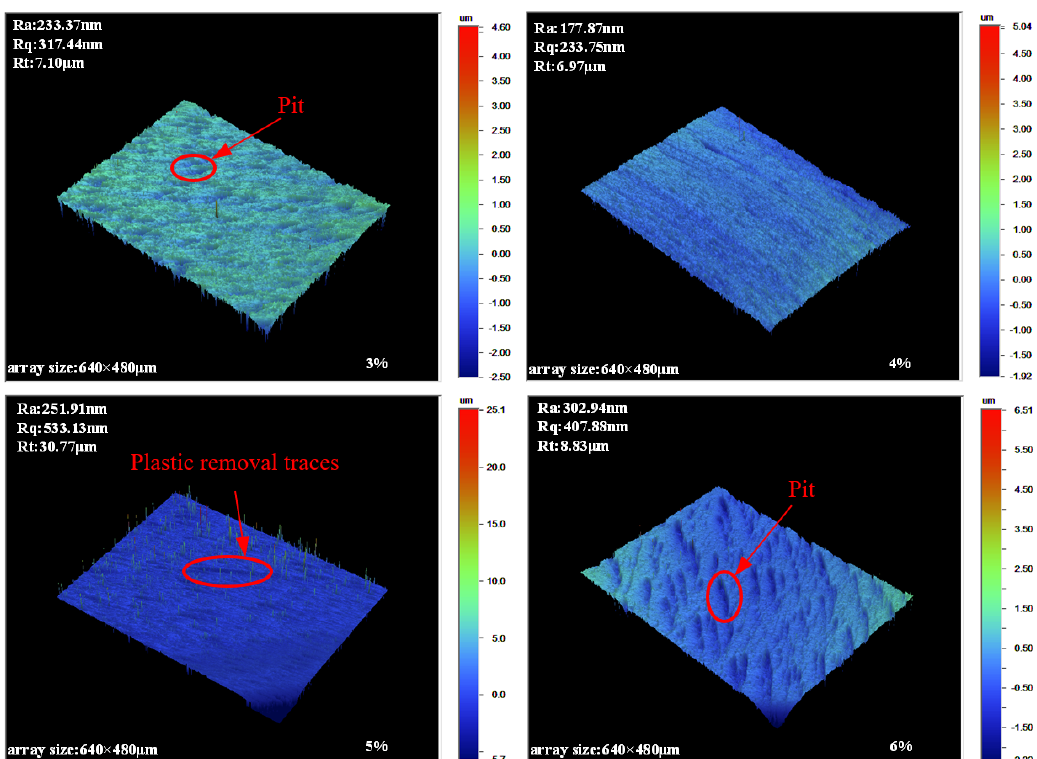
Figure 8. Micro-patterns of samples with different polishing abrasive content.